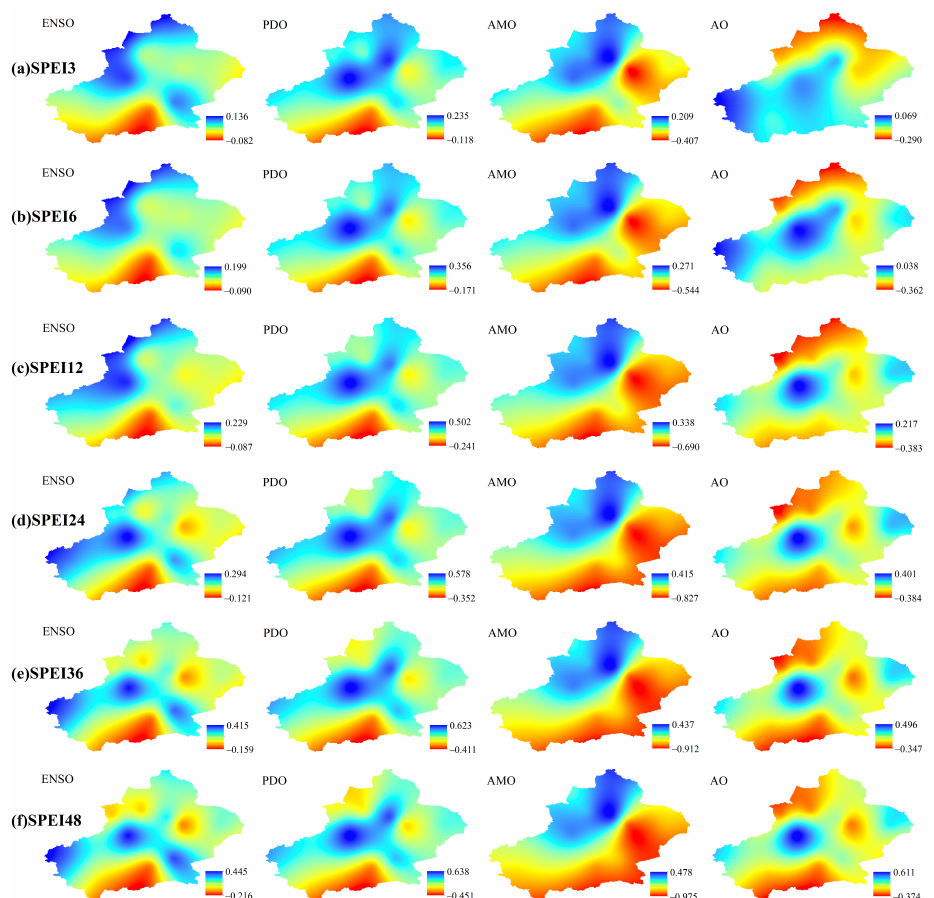
Figure 6. Spatial modes of correlation coefficient between the large scale climate variability (ENSO, PDO, AMO, and AO) and ( a ) SPEI3, ( b ) SPEI6, ( c ) SPEI12, ( d ) SPEI24, ( e ) SPEI36, and ( f ) SPEI48 based on Pearson